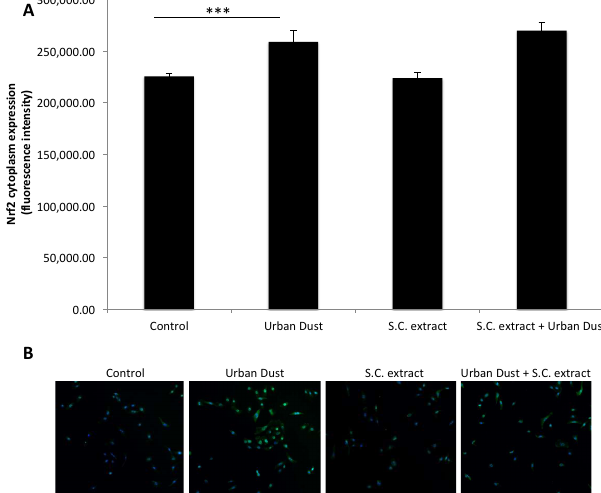
Figure 2. ( A ) Nrf2 cytoplasm expression in Normal Human Epidermal Keratinocytes after Urban Dust exposure, or co-treatment with Urban dust and S.C . extract (50 μg·mL −1 ). *** p < 0.001. ( B ) Representative pictures of Nrf2 expression: Nrf2 in green, Nucleus in blue.